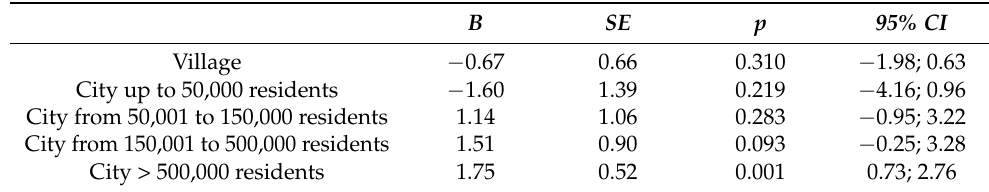
Table 6. Regression coefficients for the model considering the moderating role of the place of residence for the relationship between awareness of the possibility of a repetition of the current pandemic situation and stress. 95% CI B SE t p LL UL Constant 25.25 0.58 43.24 <0.001 24.10 26.40 Are you aware that the current 0.25 0.65 0.38 0.706 − 1.04 1.53 COVID-19 pandemic may repeat itself? W1 − 0.80 1.21 − 0.66 0.511 − 3.19 1.59 W2 − 0.16 1.16 − 0.14 0.889 − 2.45 2.12 W3 − 0.61 1.34 − 0.45 0.651 − 3.26 2.04 W4 − 0.19 0.81 − 0.23 0.818 − 1.78 1.40 Interaction 1 − 0.72 1.23 − 0.59 0.557 − 3.15 1.70 Interaction 2 0.74 1.25 0.59 0.554 − 1.71 3.21 Interaction 3 2.87 1.13 2.54 0.012 0.65 5.10 Interaction 4 2.45 0.89 2.75 0.006 0.69 4.20